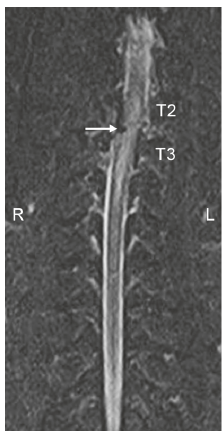
Figure 1: This image is a dorsal plane STIR MRI of the dog’s spine revealing a T2-T3 luxation. Image reveals right lateral displacement of the caudal spine at the level of T2 and T3 vertebrae. The white arrow denotes area of suspected hemorrhage and edema within the spinal canal and spinal cord